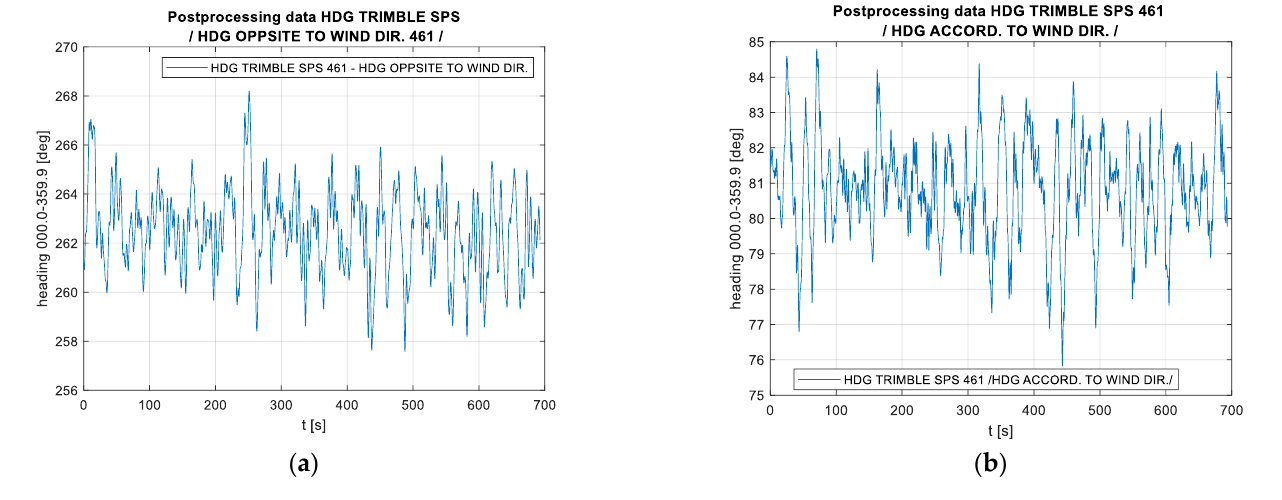
Figure 7. Typical recordings of the course made on the WildCat catamaran (time domain): ( a ) test #1, the vessel’s course is opposite to the wind direction, and ( b ) test #2, the vessel’s course follows the wind direction.